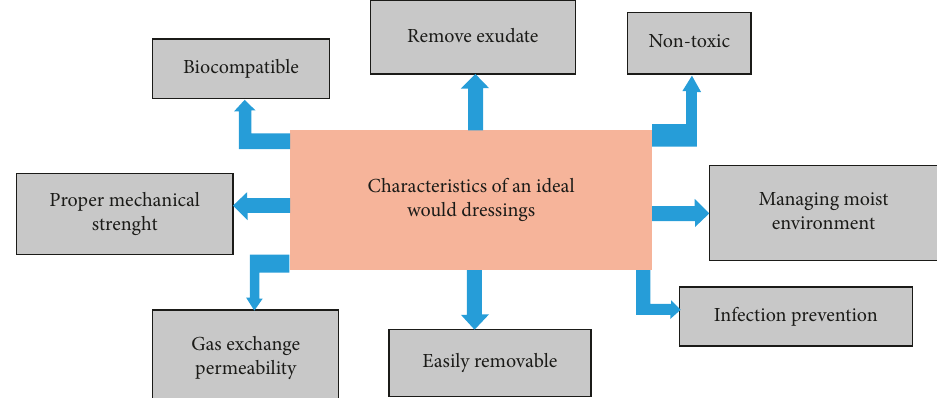
Figure 1: Ideal wound dressing required characteristics.